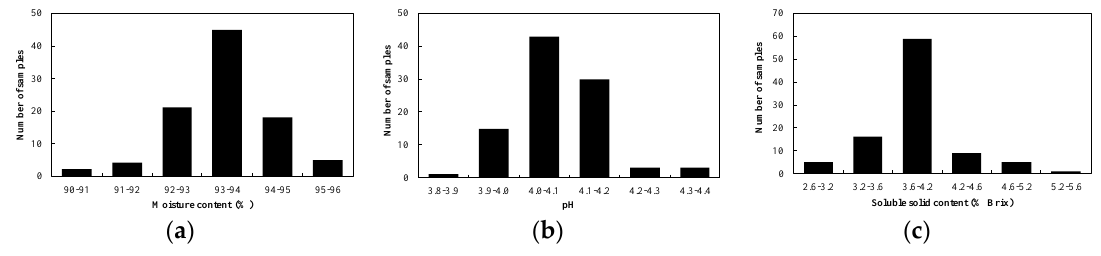
Figure 3. Distribution of ( a ) moisture content ( b ) pH and ( c ) soluble solid content measurement of intact tomatoes.